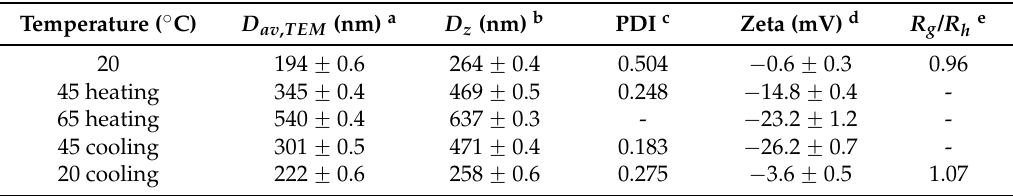
Physicochemical parameters of LCHBPNIPAM self-assemblies in aqueous